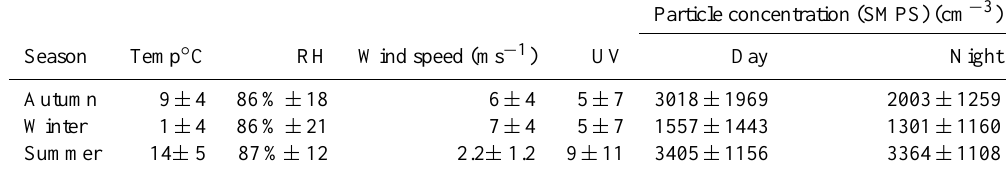
Table 1. Average meteorological parameters and particle number concentration measured at the pdD site for each of the campaigns. The errors represent one standard deviation.